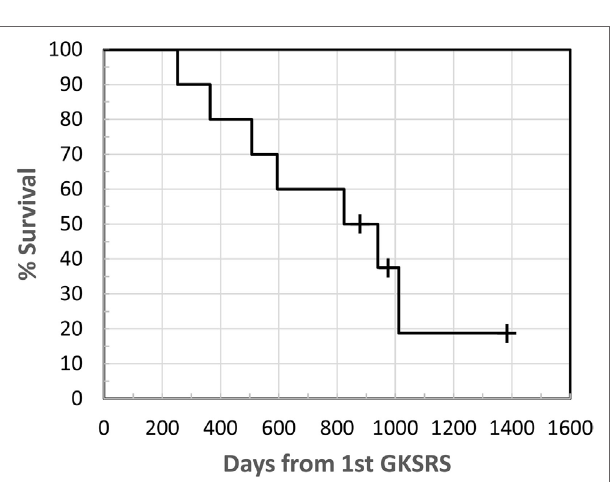
FigUre 5 | Kaplan–Meier survival plot. Survival was measured from the time of first GKSRS.